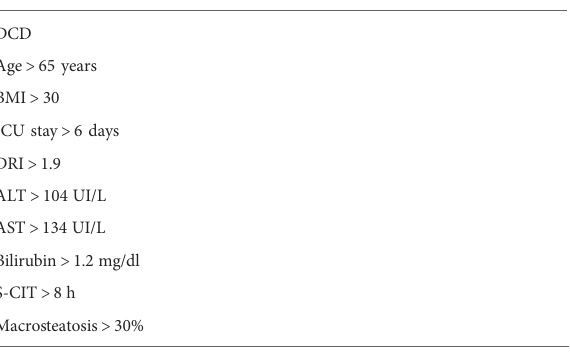
Characteristics of the recipients are shown in Table 8 : both groups of patients had similar age, BMI, cause of cirrhosis, hepatocellular carcinoma (HCC) rate, and MELD score at the time of transplant.